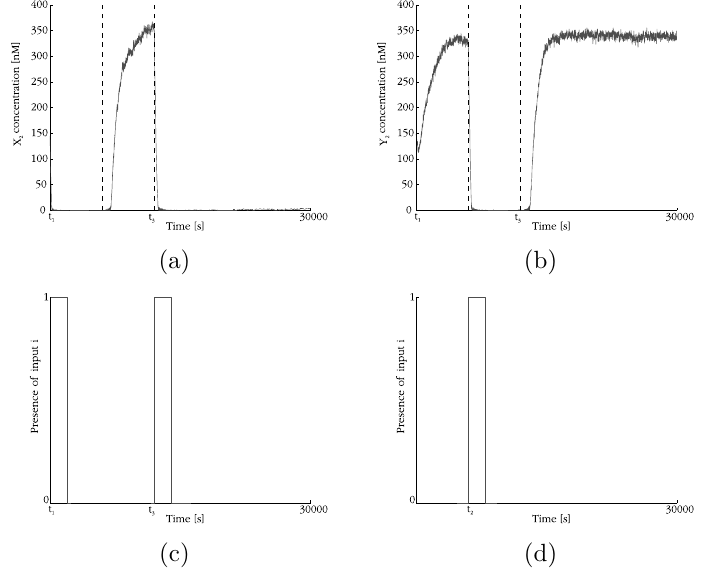
Figure 8. Switching the state of the system with external inputs introduction. Figures (a) and (b) present the courses of protein dimers concentrations ( X 2 and Y 2 ) in dependence of presence of external inputs (i.e. i and j ) which is presented in Figures (c) and